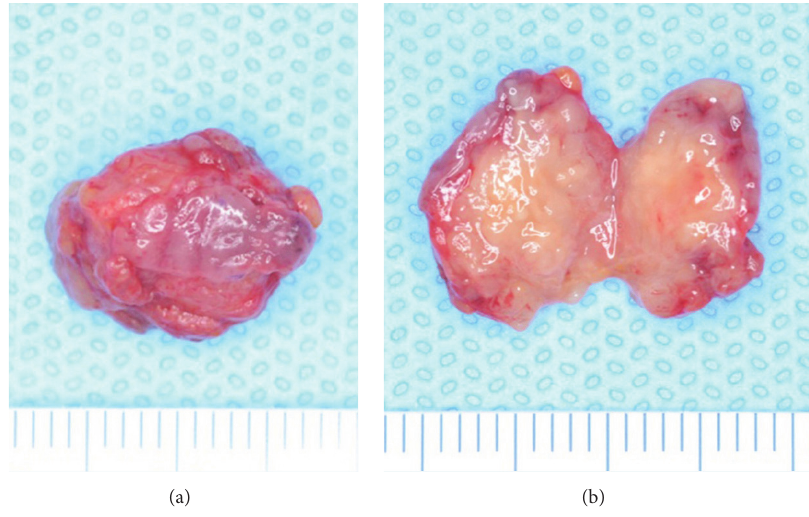
Figure 4: Excised material. (a) Whole material. (b) Cut surface.